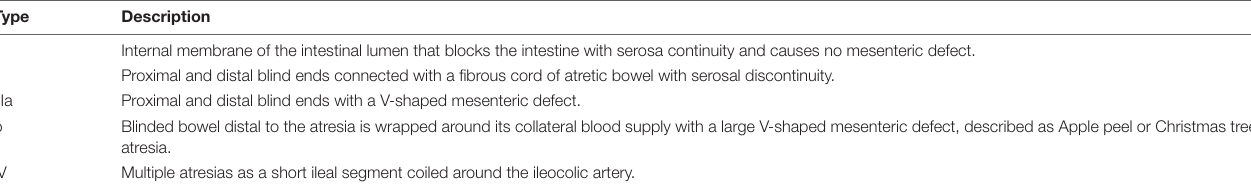
TABLE 1 | Grosfeld classification of ileal